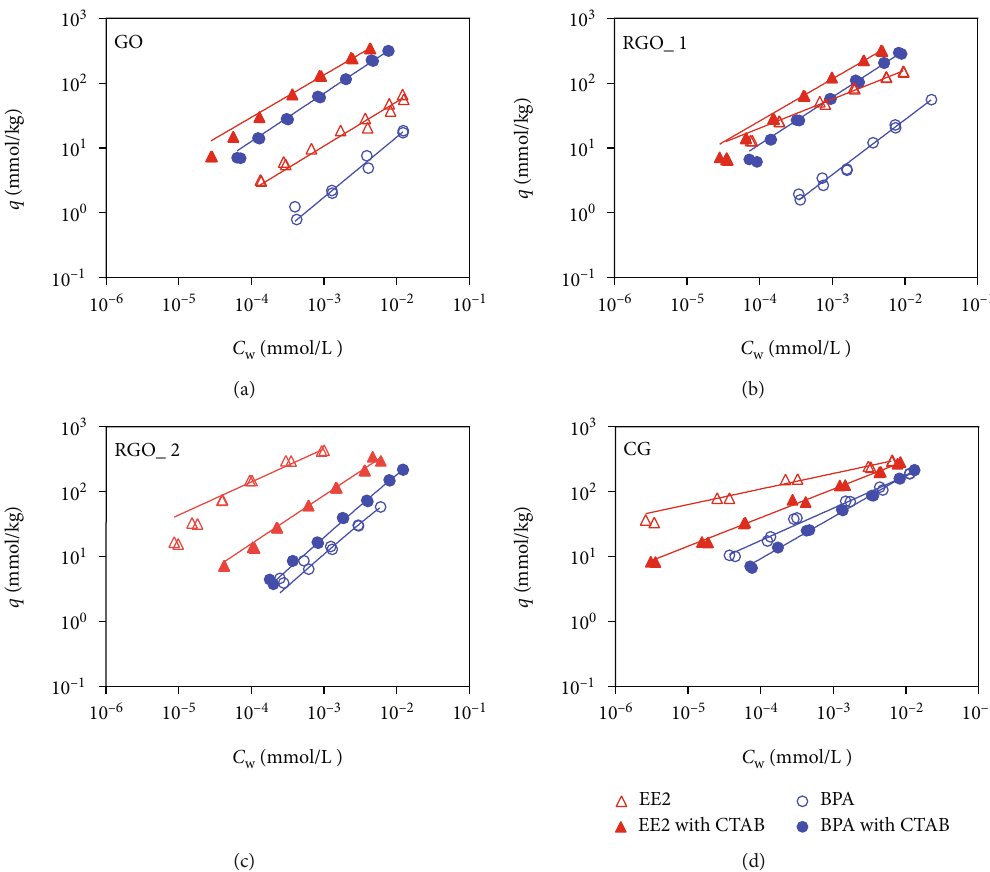
Figure 4: Adsorption isotherms of EE2 and BPA to GMs in the absence and presence of